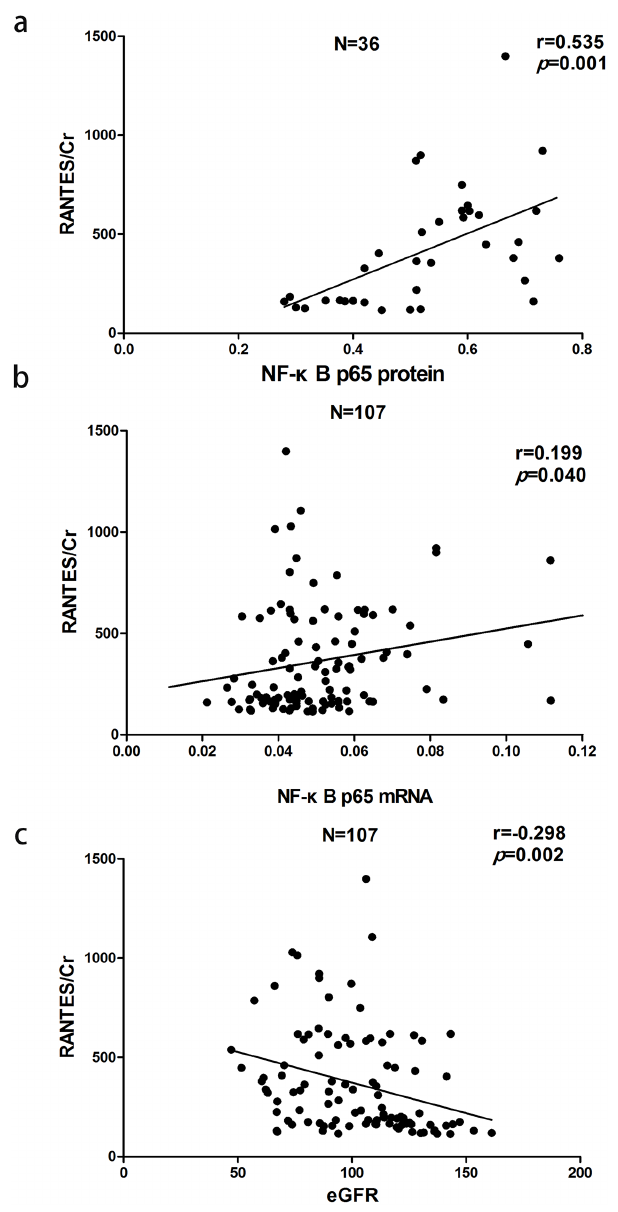
Figure 5. Correlation between urinary RANTES excretion rate and (a) nuclear NF- k B p65 protein, (b) NF- k B p65 mRNA or (c)